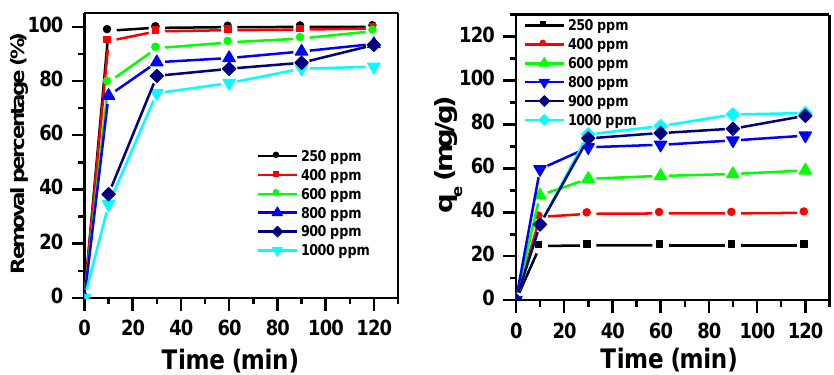
Figure 1. UV spectra of methylene blue (MB) solutions (20 ppm) before and after contact with nigella sativa (NS) and its modified derivatives.